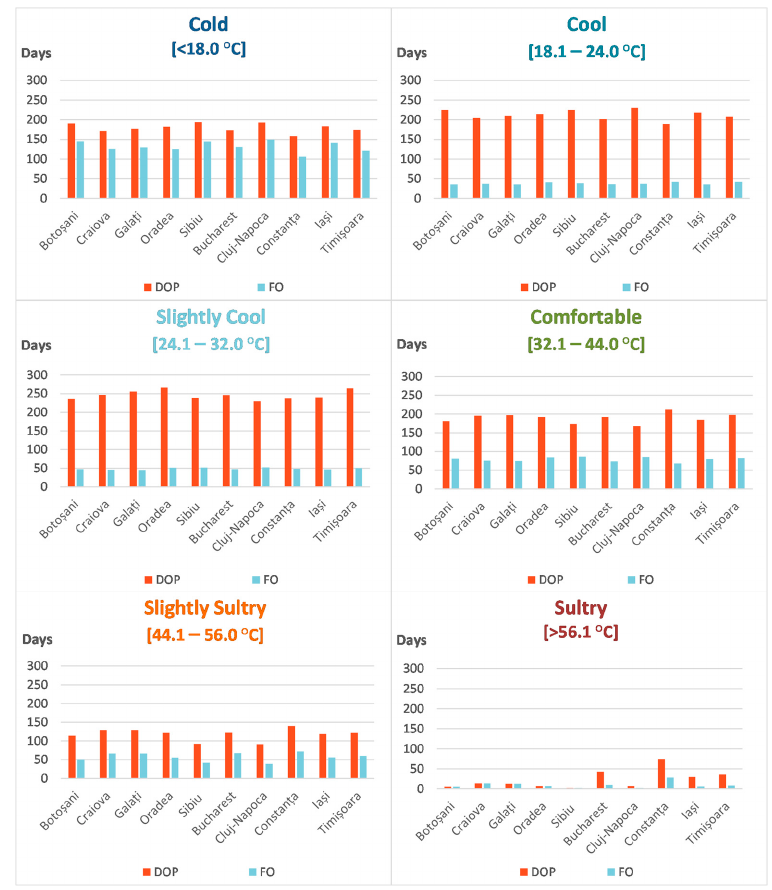
Figure 2. DOP and FO for TeK index by thermal sensations classes and weather stations (number of days).